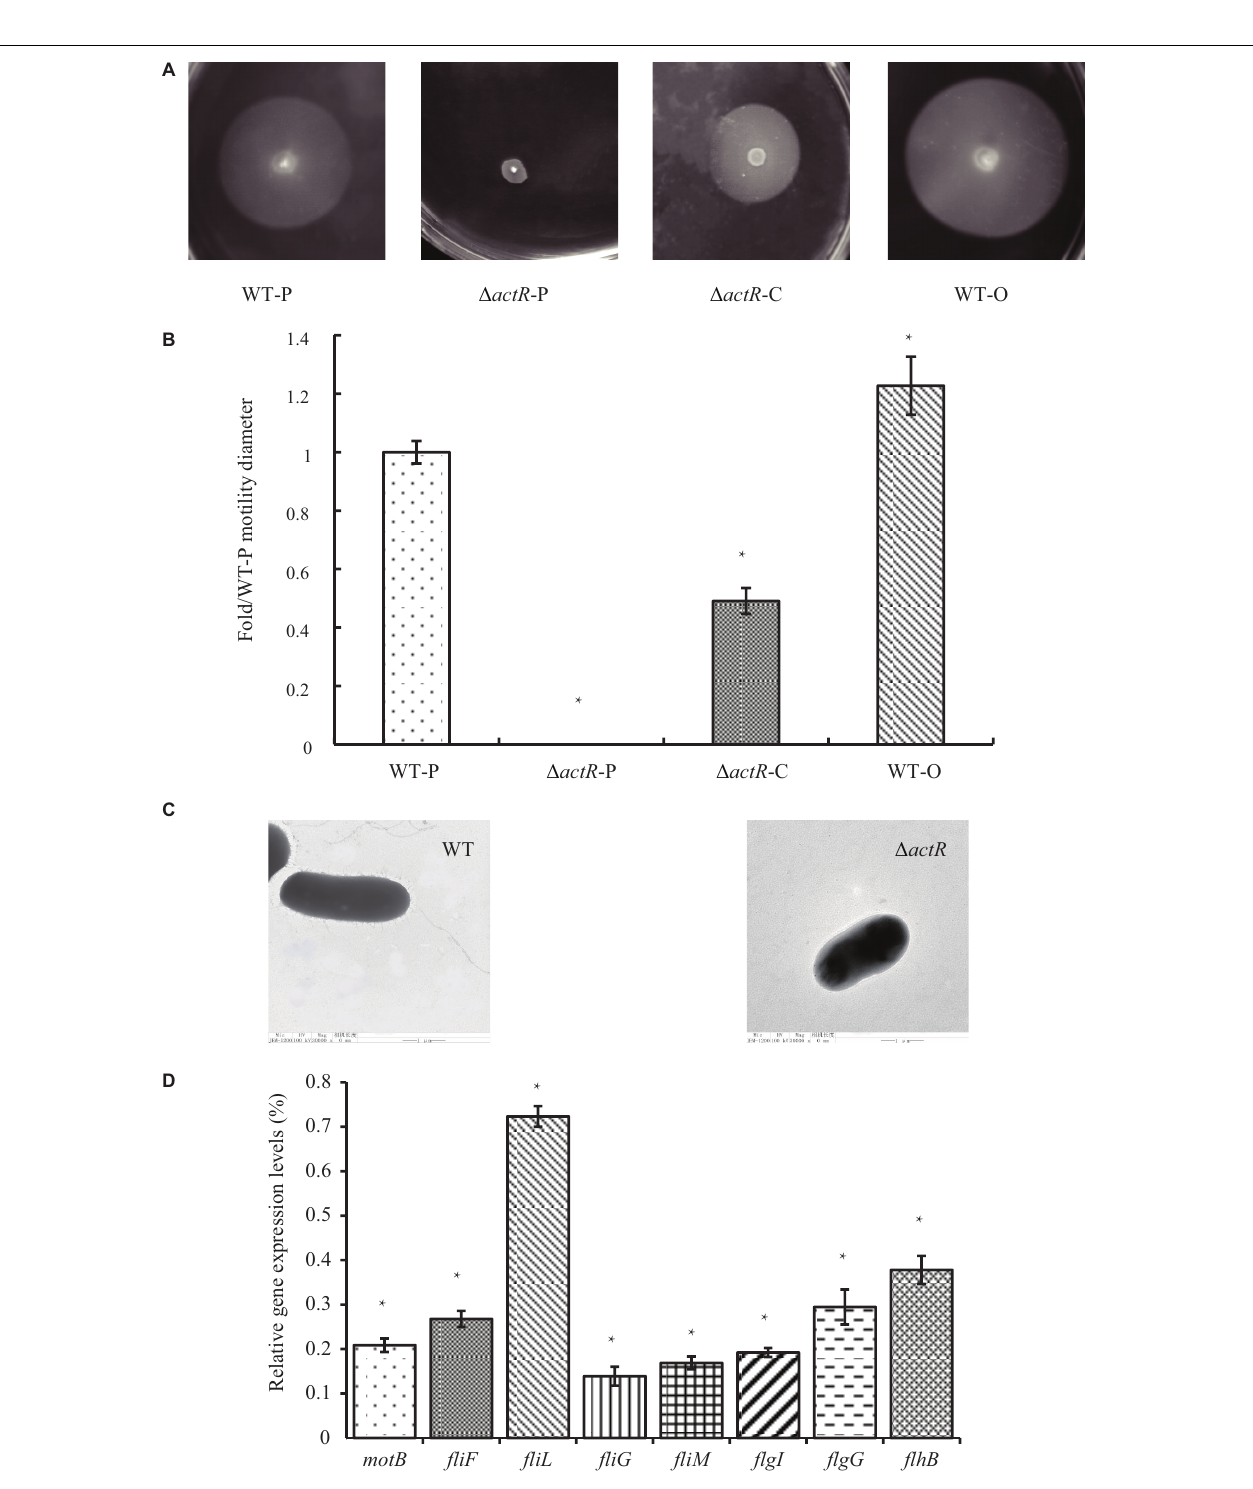
Frontiers in Microbiology |